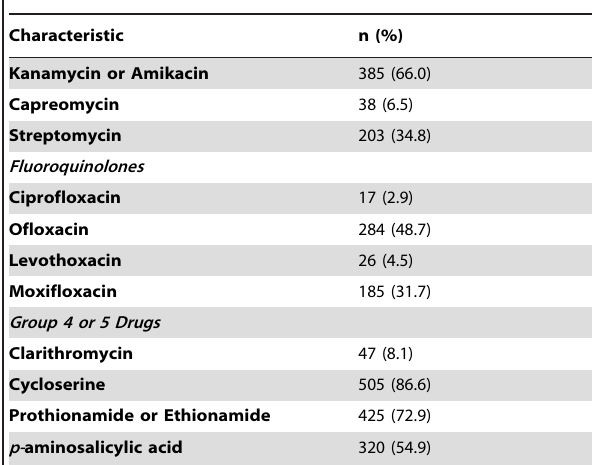
Table 1. Sociodemographic characteristics of MDR TB patients included in the present analysis (n